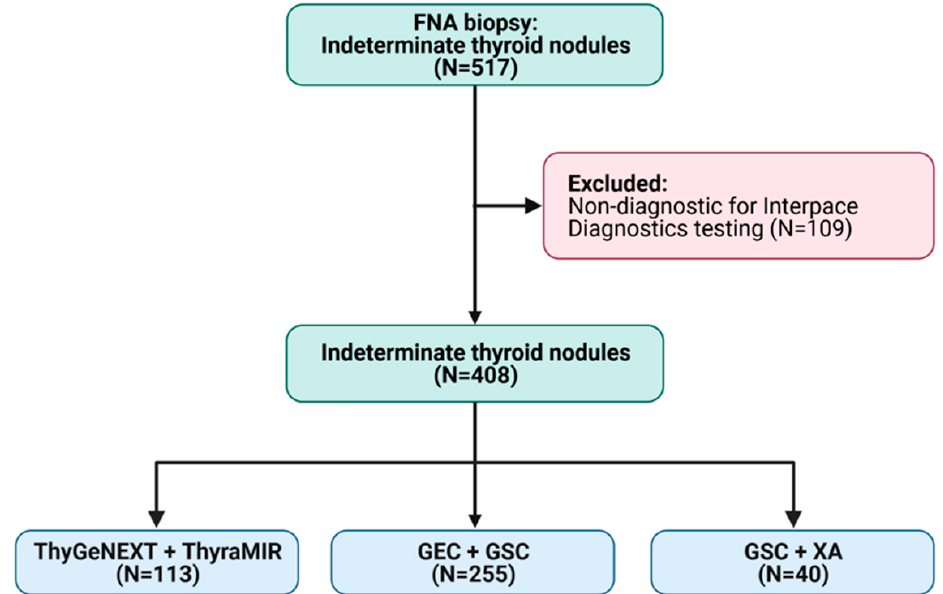
Figure 1. Breakdown of the study population. Figure made with BioRender (license: Tulane University). The breakdown of the three cohorts is shown in Table 1. All cohorts were comprised predominately of Bethesda III nodules, including at least 85% or more. Bethesda V nod- ules comprised 8.0%, 11.4%, and 10% of the nodules in the ThyGeNEXT + ThyraMIR, GEC + GSC, and GSC + XA cohorts, respectively. Finally, Bethesda IV nodules comprised only 3.5% or less in each